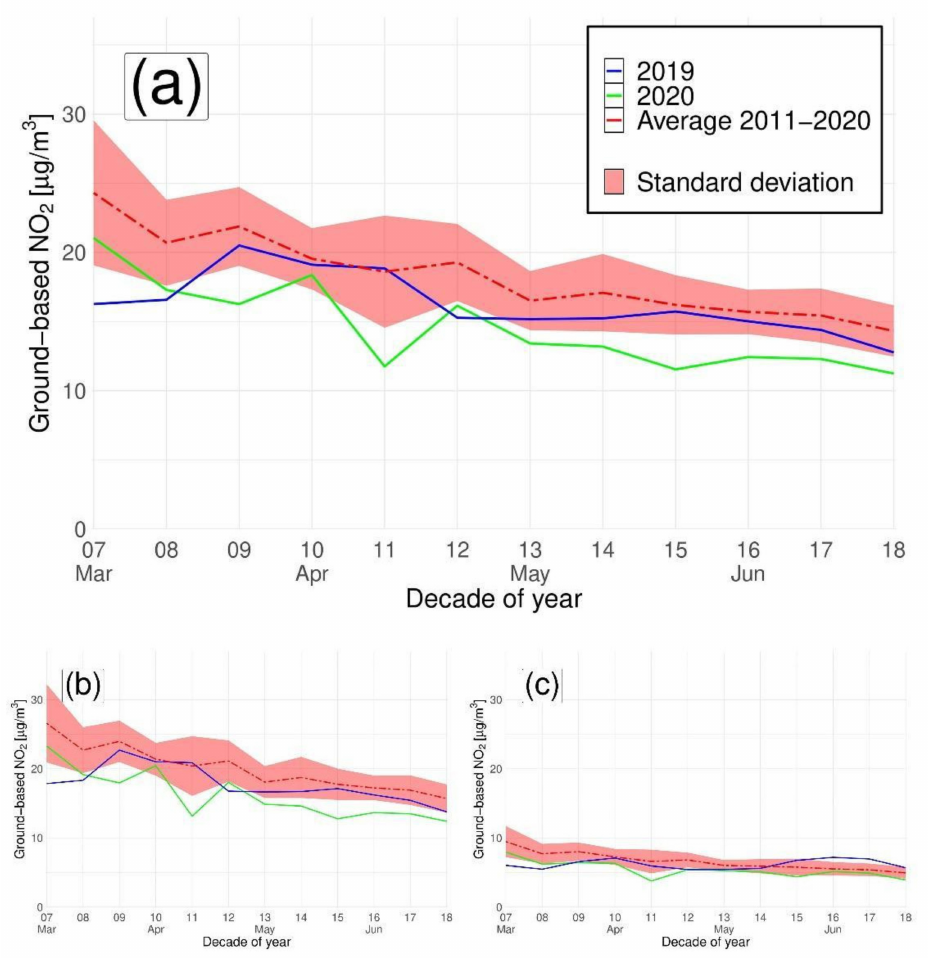
Figure 9. Mean decadal ground-based NO 2 concentrations ( µ g/m 3 ) from GIOS air quality stations in Poland in 2019 (blue line), 2020 (green line), and the 10-year multi-annual average (dashed red line). Standard deviations corresponding to multi-annual averages are marked in pink. Panel ( a ) depicts the average from all 78 stations in Poland; panel ( b ) depicts the average from 68 urban stations; panel ( c ) depicts the average from 10 non-built-up